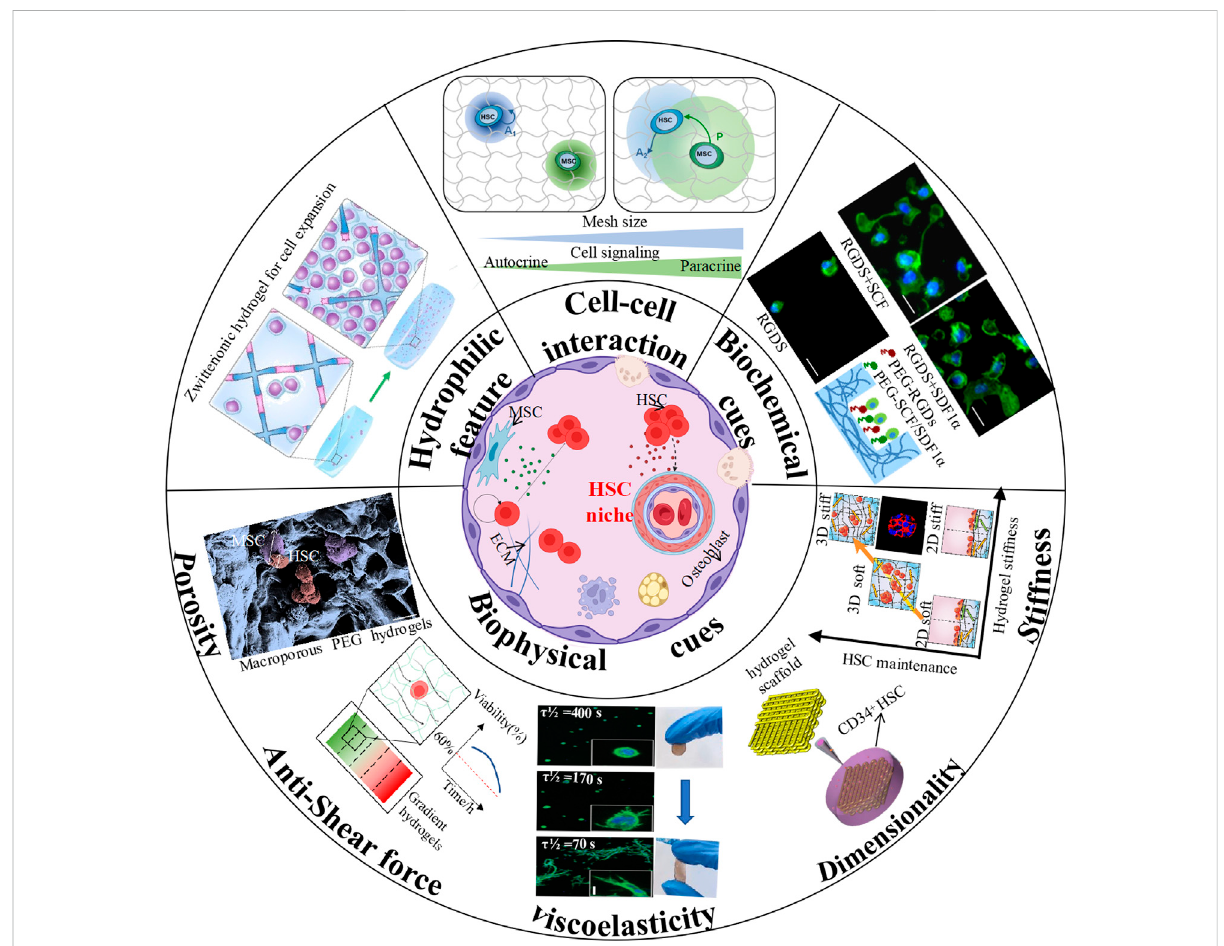
FIGURE 1 Schematic illustration of hydrogel engineering strategies for hematopoietic niche recapitulation. (Cell-cell interaction: (Gilchrist et al., 2019b) Copyright©2019.ReproducedwithpermissionfromJohnWileyandSons;Biochemicalcues:(Cuchiaraetal.,2013)Copyright©2019.Reproduced with permission from John Wiley and Sons; Stiffness: (Gvaramia et al., 2017) Copyright © 2017. Reproduced with permission from Elsevier;